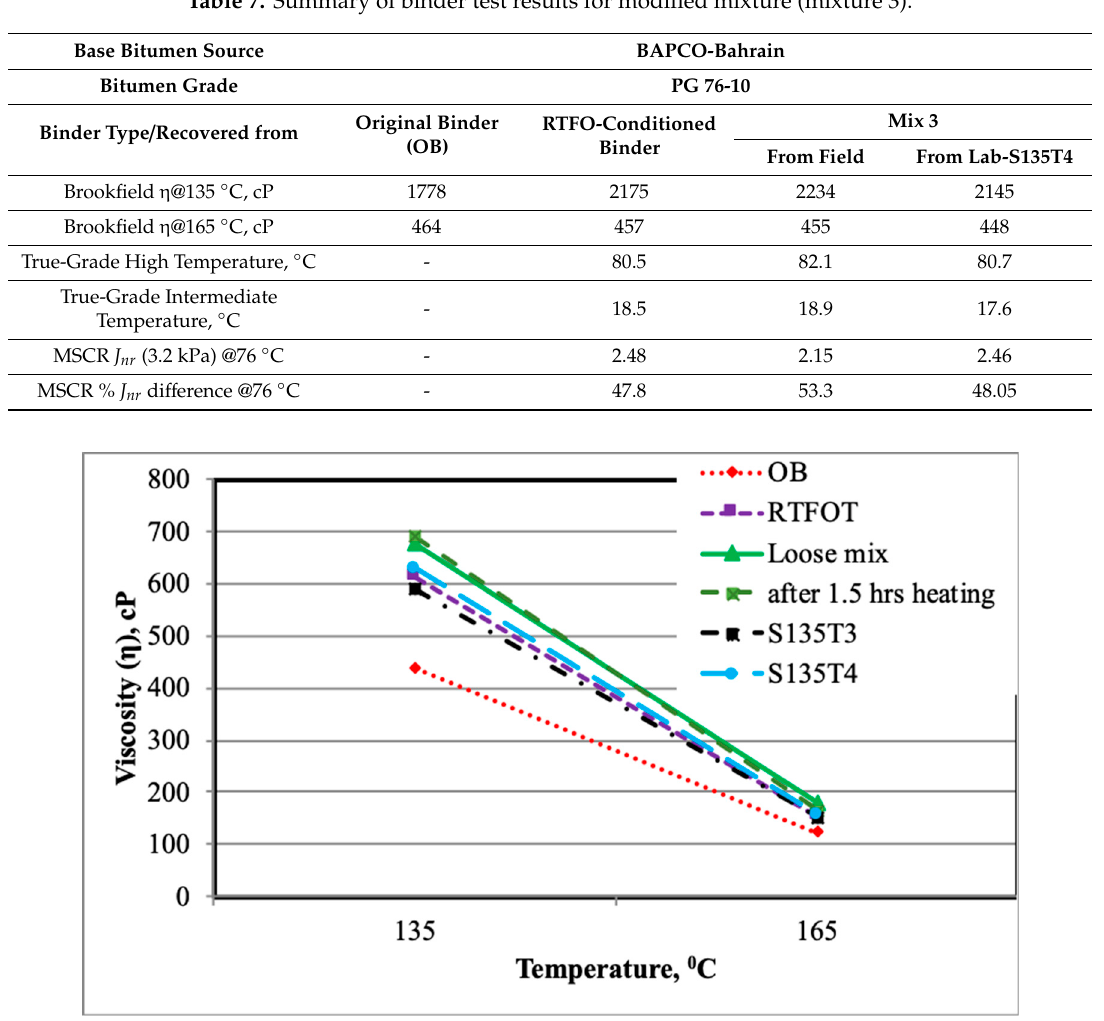
Figure 10. Comparison of viscosity results of unmodified binders recovered from mixture 1.